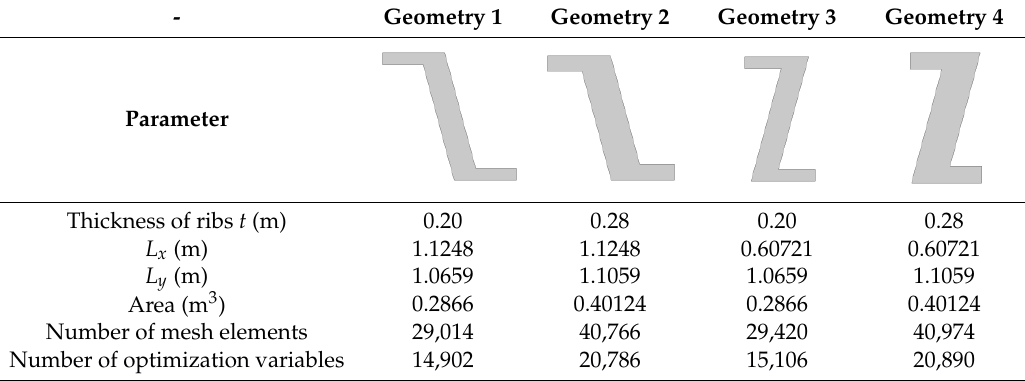
Figure 1. The geometry of the quarter of: ( a ) re-entrant honeycomb; ( b ) honeycomb; boundary conditions for: ( c ) re-entrant honeycomb; ( d ) honeycomb geometries. Also, two values of the parameter t are considered, which means that the thickness of the ribs equals either 0.2 or 0.28. In all cases, the value of the rib length L was constant and resulted from the length of the side of a regular hexagon inscribed in the circle of radius equalling 1. On the basis of the length L and the angle α = 15°, the dimensions of the cell L x and L y are calculated. All these values are collected in Table 1. Table 1. The values of geometrical characteristics, number of finite elements, and number optimization variables of considered geometries.